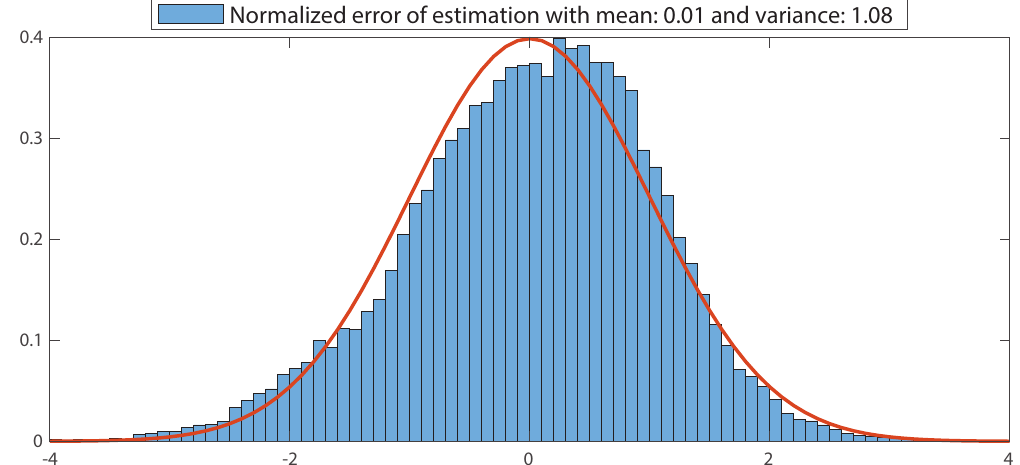
Figure A7. Histogram of the normalized error of estimation (Equation (15)) over all radars. The red curve is the standard normal distribution which should be matched by the histogram in case of ideal estimation.